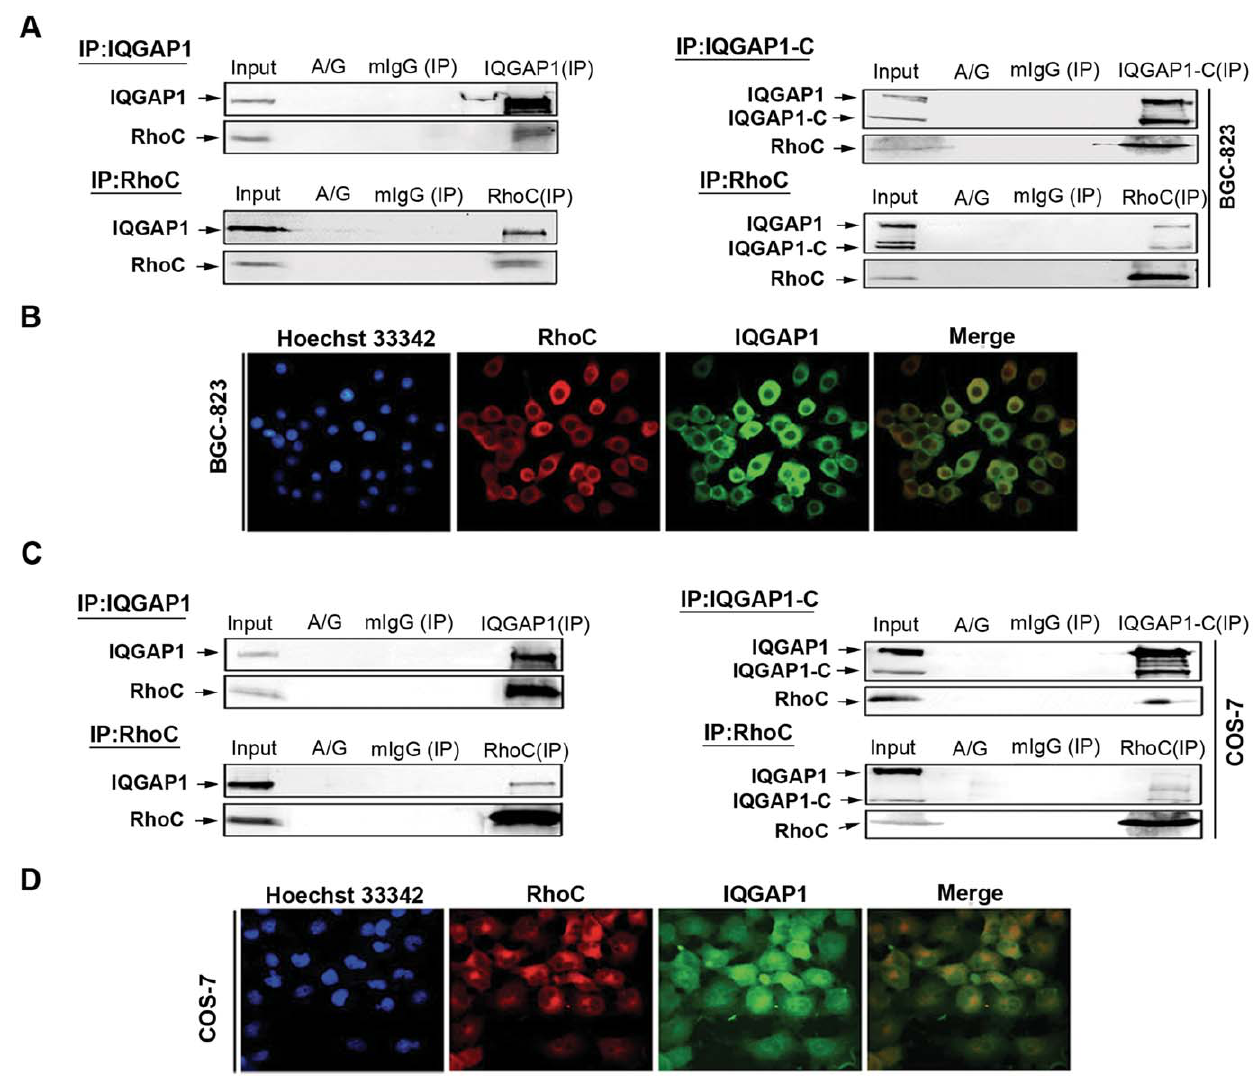
Figure 5. Identification of the interaction between RhoC and IQGAP1. ( A ) BGC-823 cells growing on 100 mm plates were transiently co- infected with Ad-IQGAP1 and Ad-RhoC-V14, or Ad-IQGAP1-C and Ad-RhoC-V14 for 48 h. The cells were lysed and equal amounts of lysate protein were immunoprecipitated (IP) with anti-RhoC, anti-IQGAP1 antibodies or isotype-matched IgG. Whole cell lysate was used as a protein input control. ( B ) BGC-823 cells were transfected with above adenovirus for 24–48 h, and the co-localization of RhoC and IQGAP1 in cells were determined by Immunofluorescence microscopy using anti-RhoC and anti-IQGAP1 antibodies. Nuclei were stained by Hoechst 33342 (blue). ( C ) COS-7 cells were transiently co-infected with Ad-IQGAP1-C/Ad-IQGAP1 and Ad-RhoC-V14 for 48 h. The cells were undergoing the same Co-IP procedure described above. ( D ) COS-7 cells were transfected with above adenoviral vectors for 24–48 h, and the co-localization of RhoC and IQGAP1 in cells were shown by Immunofluorescence. The data are representative from three independent experiments with similar